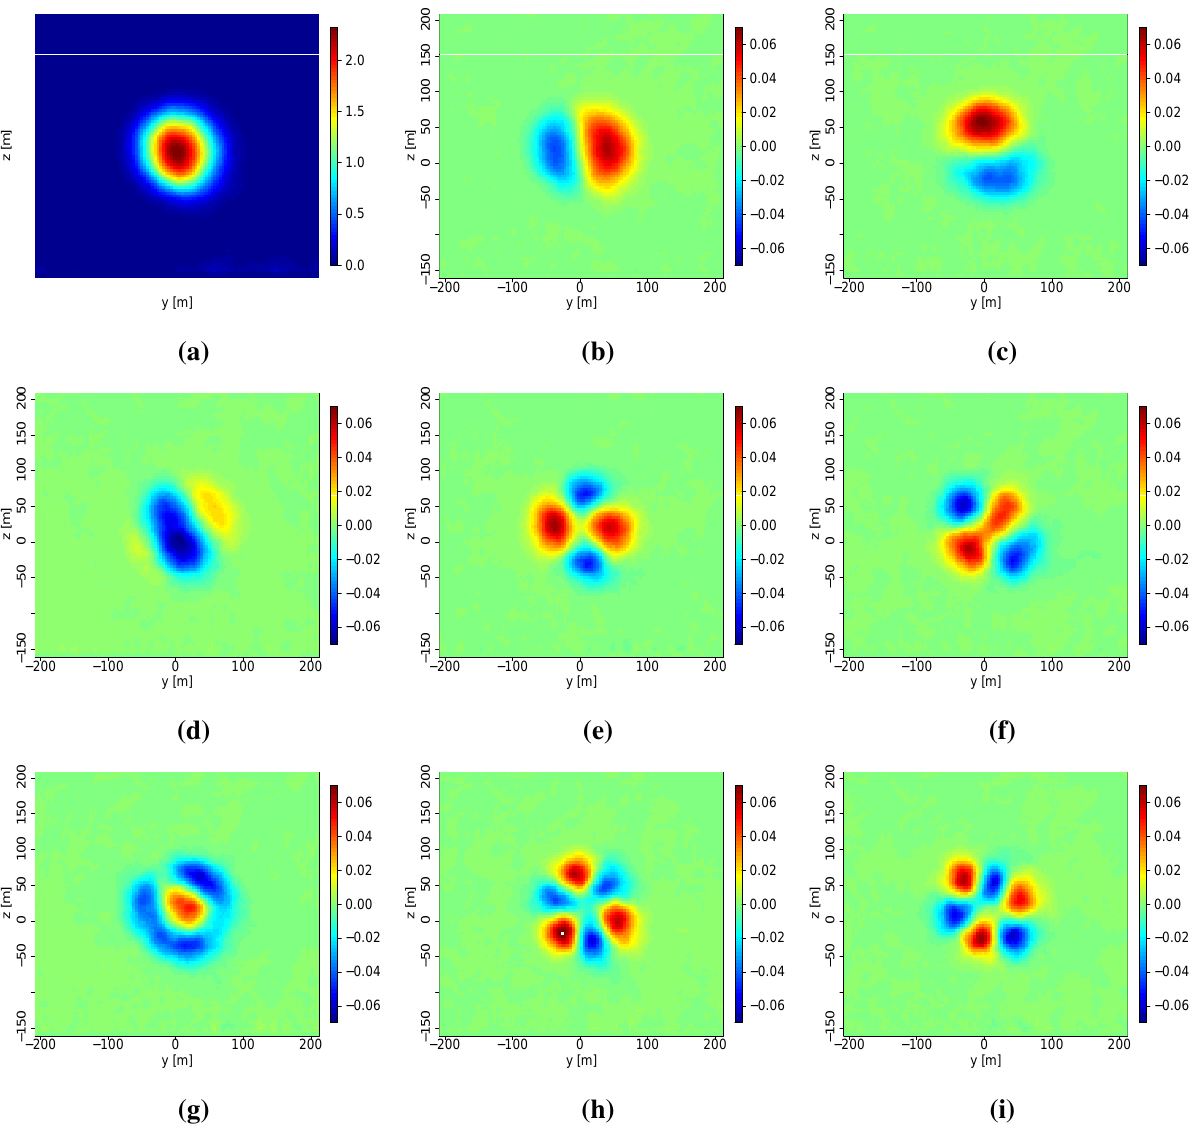
Figure 3. Mean field and POD modes of the preprocessed field ˜ u . ( a ) Mean field; ( b ) Mode 1; ( c ) Mode 2; ( d ) Mode 3; ( e ) Mode 4; ( f ) Mode 5; ( g ) Mode 6; ( h ) Mode 7; ( i ) Mode